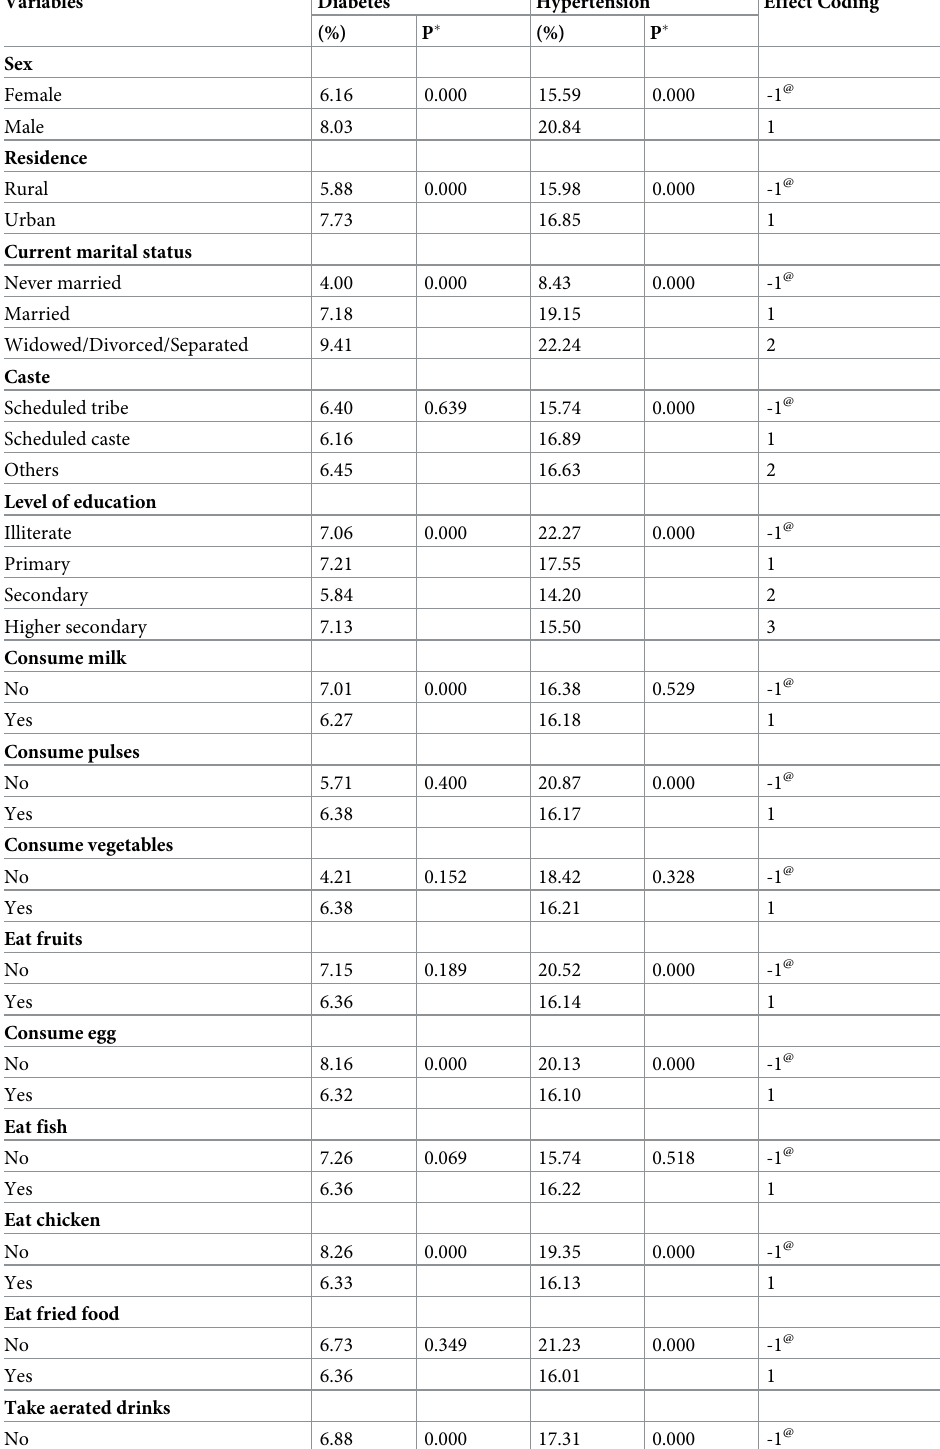
Table 1. Prevalence of diabetes and hypertension among adults aged 15–49 years by fixed covariates with effect coding used in the model).